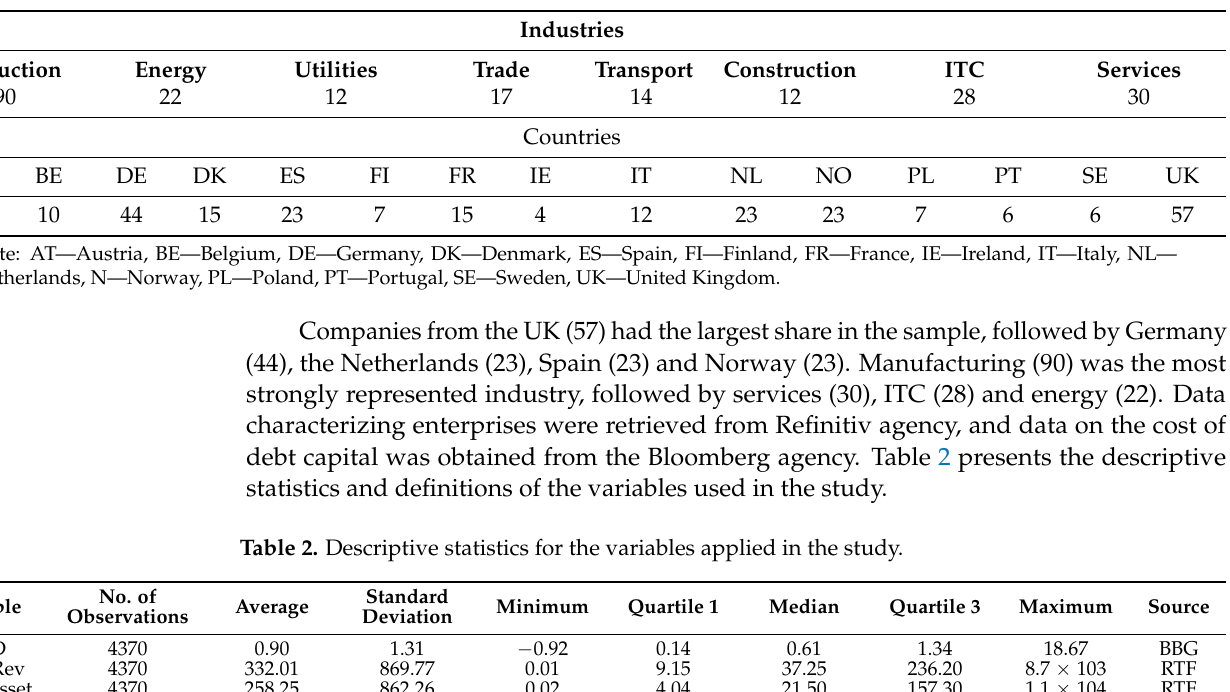
Table 1. Distribution of companies by industries and countries.